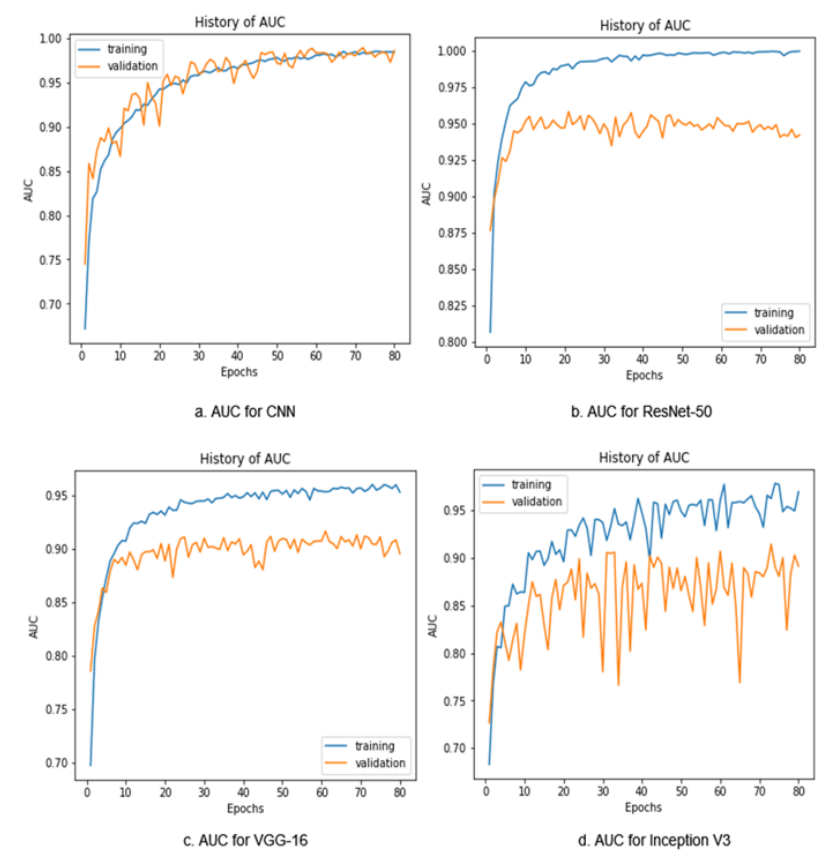
Figure 10. AUC graph for the CNN, ResNet-50, Inception V3, and